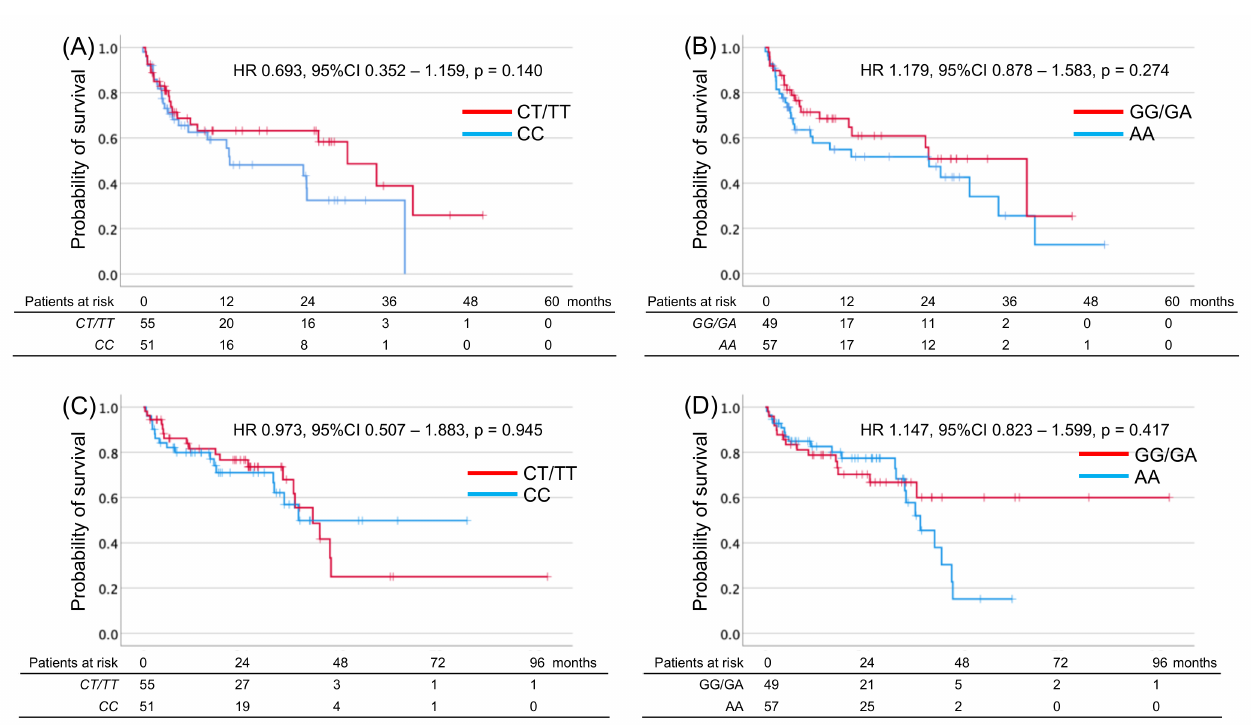
Figure 1. Kaplan–Meier estimates of progression-free survival (PFS) and overall survival (OS) in